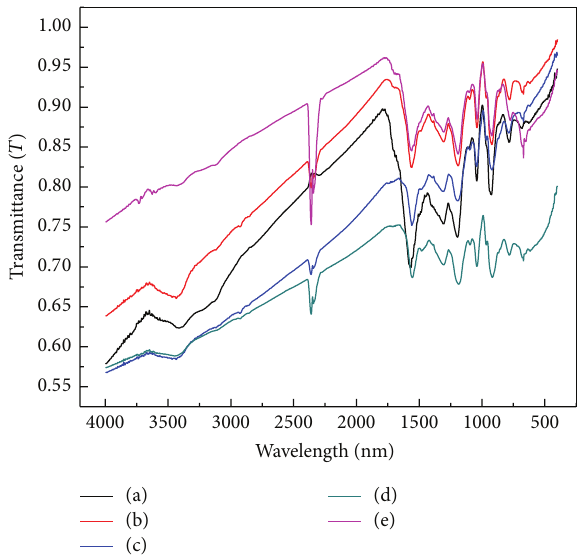
Figure 1: FTIR spectra of (a) 1wt% Ppy/TiO 2 , (b) 2wt% Ppy/TiO 2 , (c) 3 wt% Ppy/TiO 2 , (d) 4 wt% Ppy/TiO 2 , and (e) 5 wt% Ppy/TiO 2